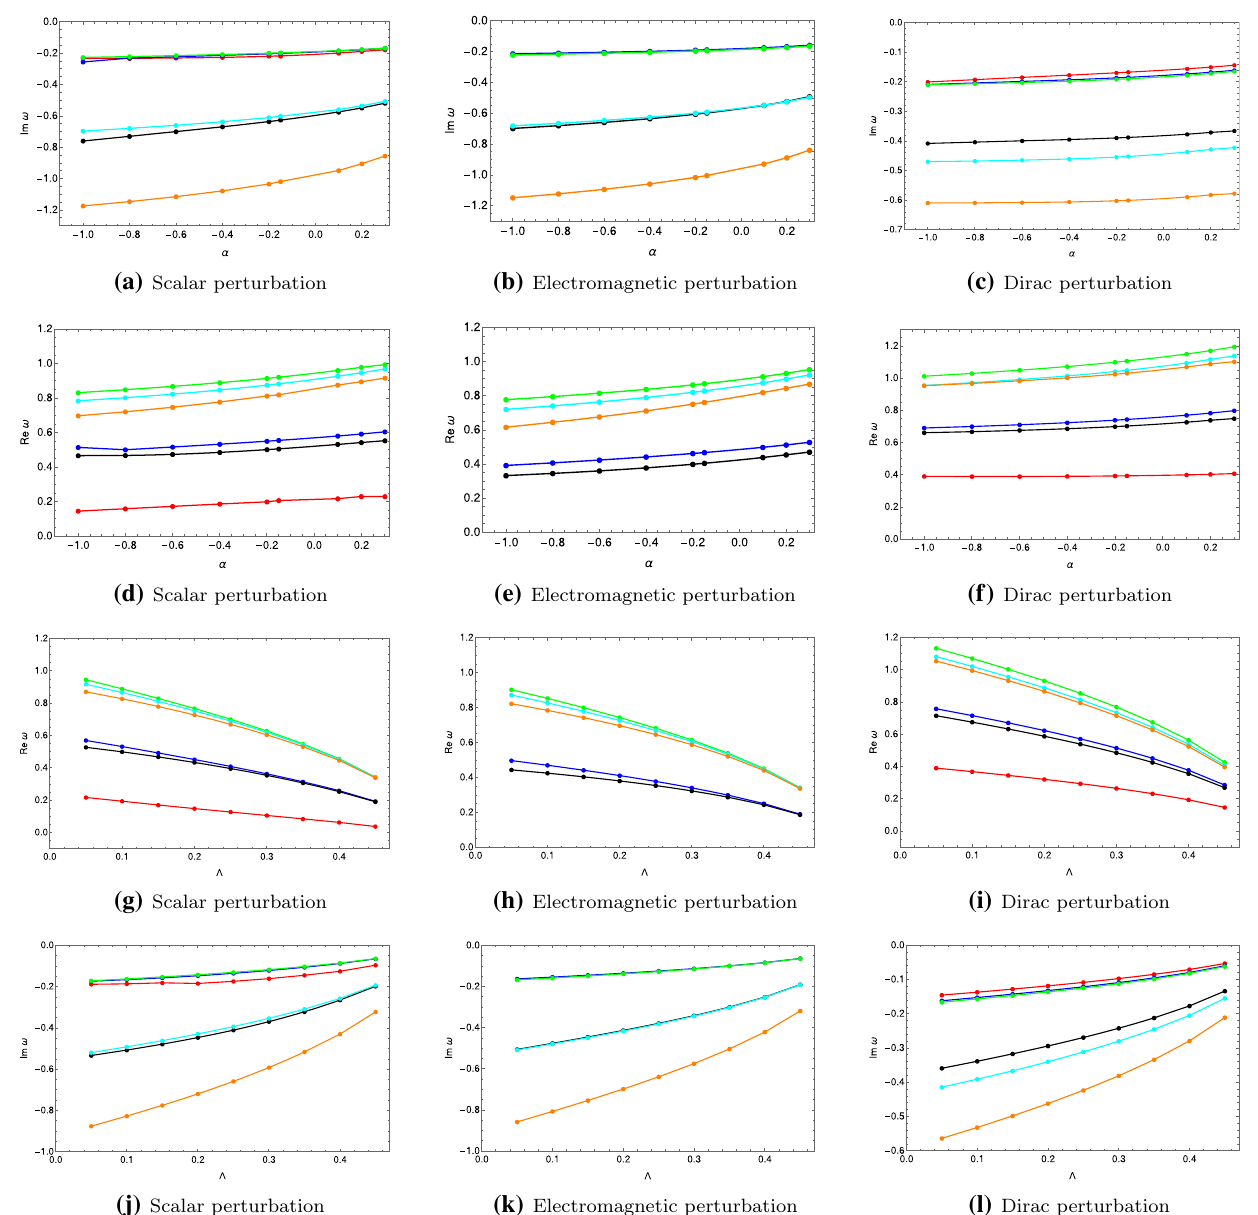
Fig. 2 The figure plots the real and imaginary parts of the quasinormal frequencies vs the different parameters (α,(cid:3)) of the four dimensional Gauss–Bonnet de Sitter spacetime, for different types of perturbations,